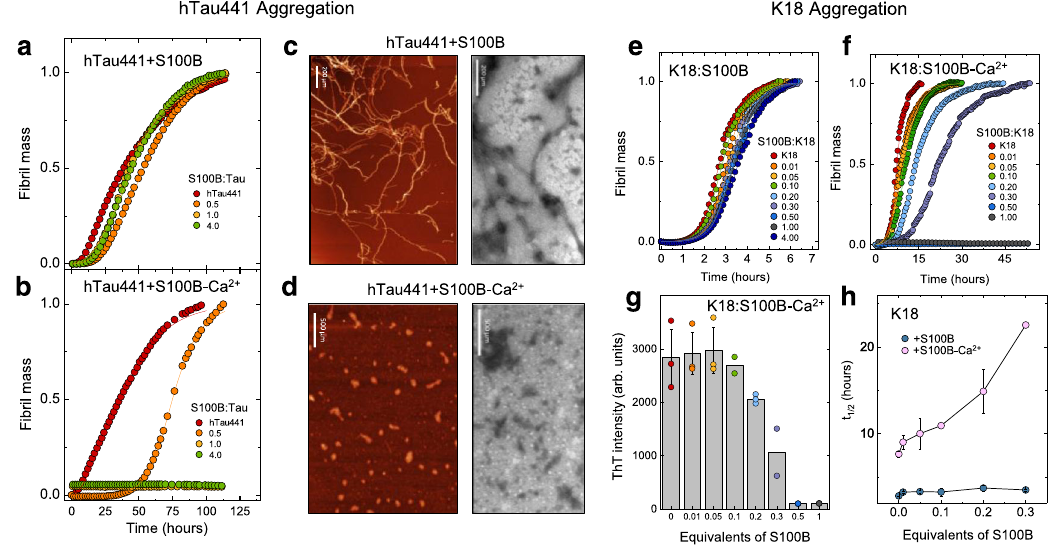
Fig. 4 S100B-Ca 2 + inhibits full-length tau and K18-fragment aggregation. a , b Fibril formation of 25 µ M hTau441 (red) in 50 mM Tris, pH 7.4, in the absence ( a ) or the presence ( b ) of 1.1 mM CaCl 2 at 37 °C under agitation in the presence of 0.5 (orange), 1.0 (yellow), and 4.0 (green) molar equivalents of S100B. Aggregation induced by 0.5 mg/mL heparin addition. c , d AFM (left) and TEM (right) imaging of end-time species of hTau441 aggregation in the absence ( c ) or the presence ( d ) of Ca 2 + at 10 µ M tau and at a S100B:tau molar ratio of 1. Scale bars, 200 µ m ( c ) and 500 µ m ( d ). Independent experiments of AFM and TEM morphological analysis were performed at least three times. e , f Fibril formation of 10 µ M K18 (red) in 50 mM Tris, pH 7.4, in the absence ( e ) or the presence ( f ) of 1.1 mM CaCl 2 at 37 °C under agitation in the presence of 0.01 (orange), 0.05 (yellow), 0.1 (green), 0.2 (light blue), 0.3 (purple), 0.5 (blue), 1.0 (gray), and 4.0 (dark blue) molar equivalents of S100B. Aggregation induced by 90 µ g/mL heparin addition. Plots represent averaged normalized intensity curves obtained from three independent replicates for each of the tested conditions. g ThT intensity in arbitrary units (arb. units) of end-time point K18 aggregation in the presence of 1.1 mM CaCl 2 (same color code); h half-time of K18 aggregation in the absence (blue) or the presence (light pink) of 1.1 mM CaCl 2 . Data are presented as mean values± SD from n = 3 independent experiments except for samples with 0.1 and 0.3 equivalents of S100B for which n = 2. See Methods for